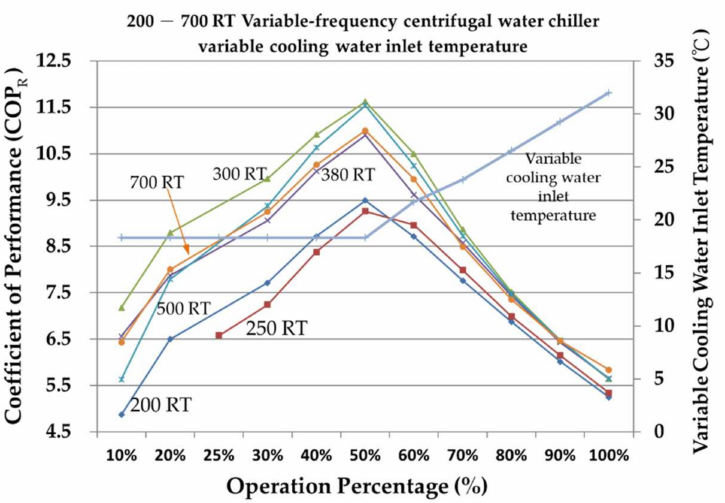
Figure 15. Variable-cooling water inlet temperature COP R of the 200–700 RT variable-frequency water chiller.